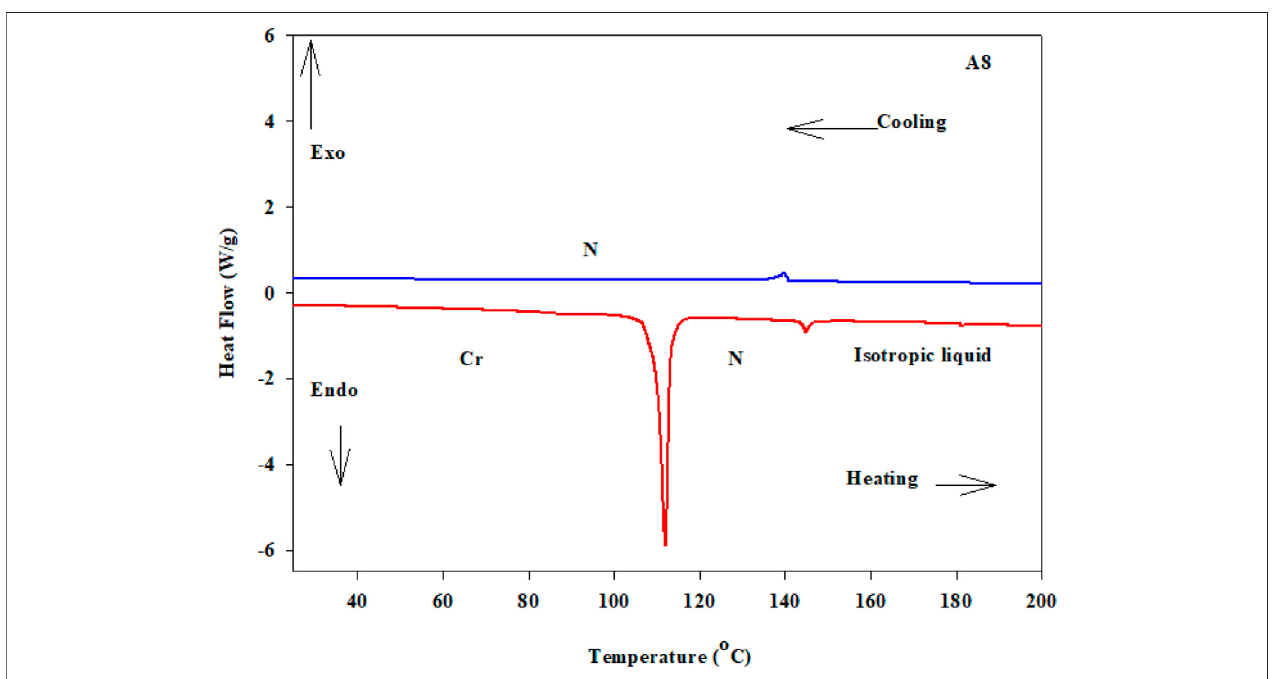
FIGURE 4 | DSC thermograms of derivative A8 with heating /cooling rate of ± 10 ° C/min.